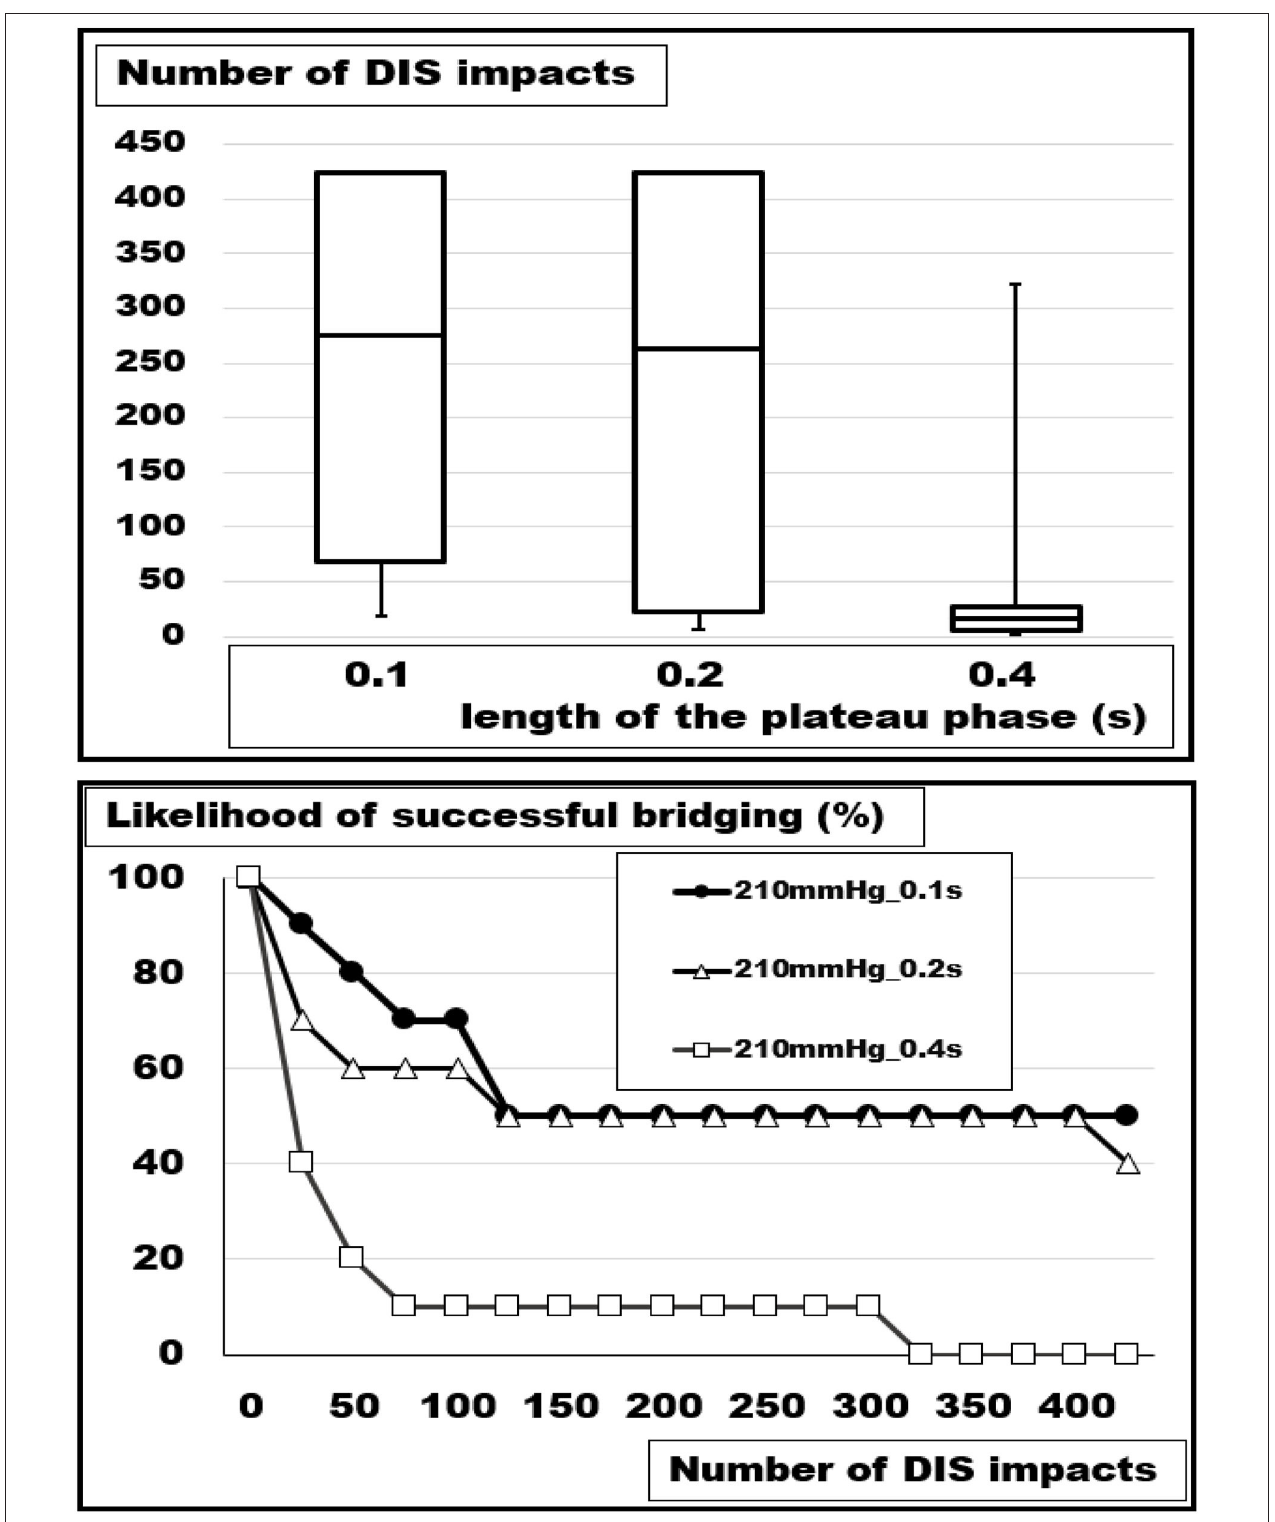
FIGURE 5 | (Top) Box- and whisker-plots and (bottom) likelihood curves of the number of DIS impacts withstood at plateau lengths of 0.1, 0.2, and 0.4s. An increasing load destabilizes the reconstruction of a 5cm orifice bridged with square Dynamesh Cicat® hernia meshes without fixation (Kruskal-Wallis: p = 0.00852; u- test.1 vs.0.4 p =